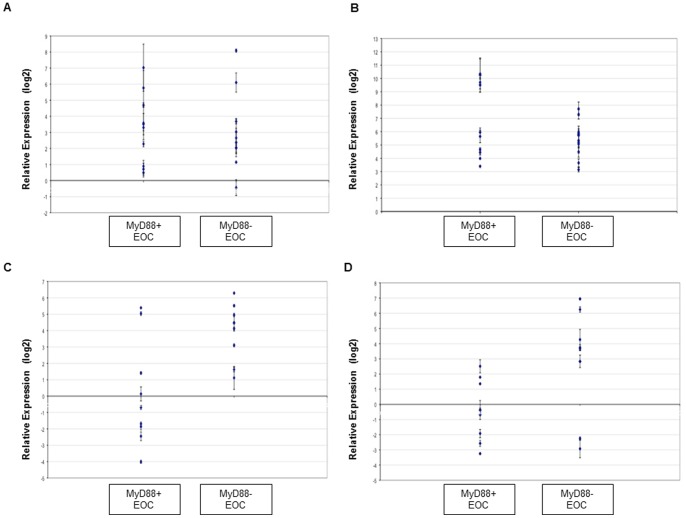
TLR4/MyD88 mRNA and miR-21 & miR-146a expression.Scatter plots showing relative gene and microRNA expression with standard deviation (fold changes calculated via the 2−ΔΔCt method). 22 EOC cases (serous carcinomas) grouped as MyD88+ or MyD88- based on protein expression; data shown relative to each group. A & B, TLR4 & MyD88 mRNA statistically unchanged between MyD88 positive & MyD88 negative groups (p>0.05); C & D, levels of both miR-21 & miR-146a up-regulated in MyD88 negative EOC (p<0.05).